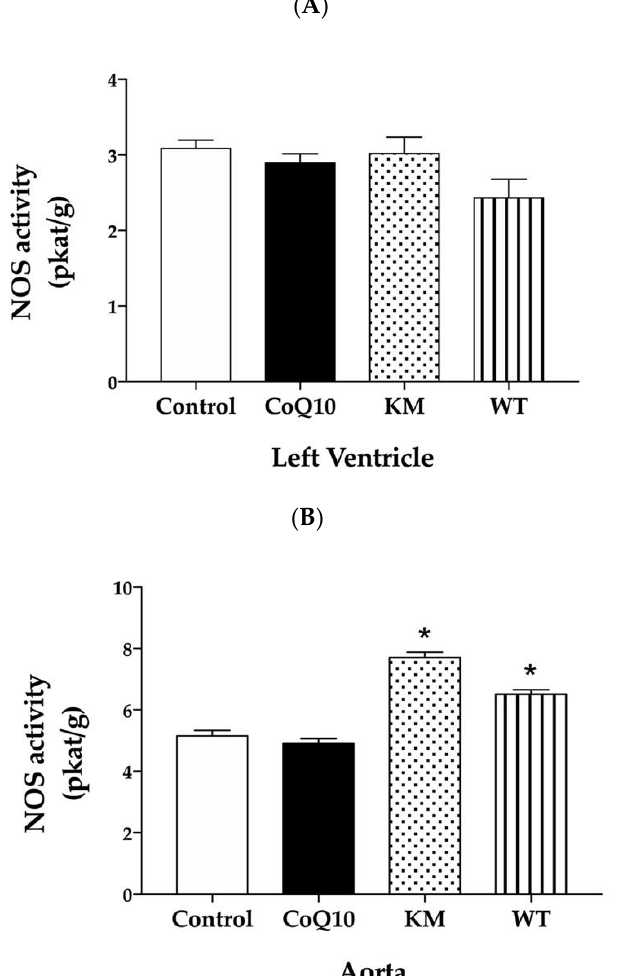
Figure 1. Effect of CoQ10, KM, and WT on total nitric oxide synthase (NOS) activity in the left ventricle (LV) ( A ) and aorta ( B ). CoQ10—coenzyme Q10, KM—Koralovij Marka, WT—Wild Type. Data are means ± SEM from 6 animals in each group. * p < 0.01 compared to the control group.